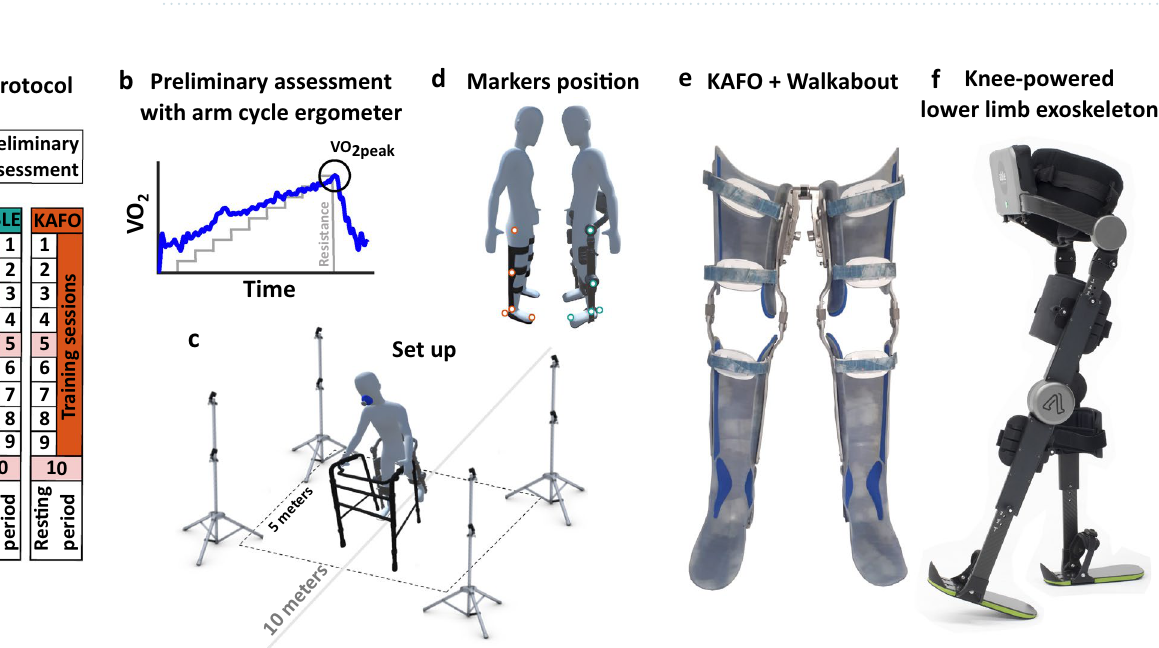
Table 1. Patient demographics. M: Male, F: Female, K: KAFOs, A: ABLE Exoskeleton.